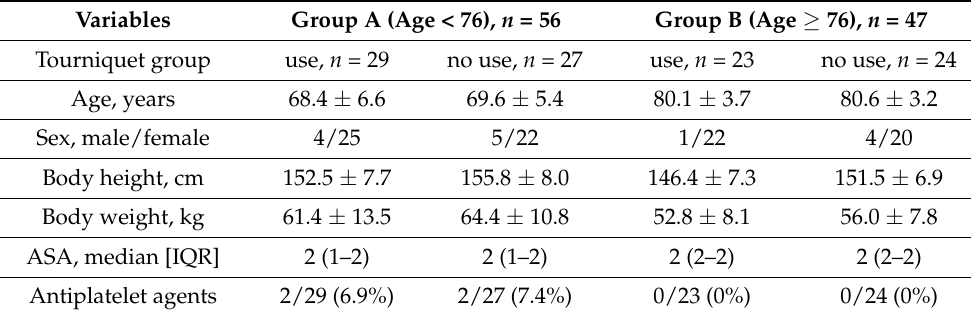
Table 1. Demographic data of the patients. Means ± standard